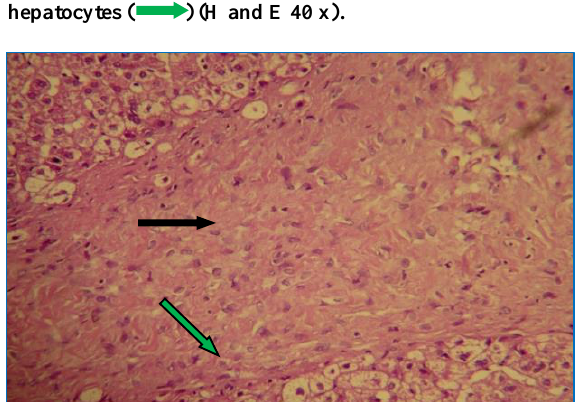
Figure, 3: G2: Liver of rabbit at 10 days postinfection show severe hemorrhage ( ) (H and E 40 x).